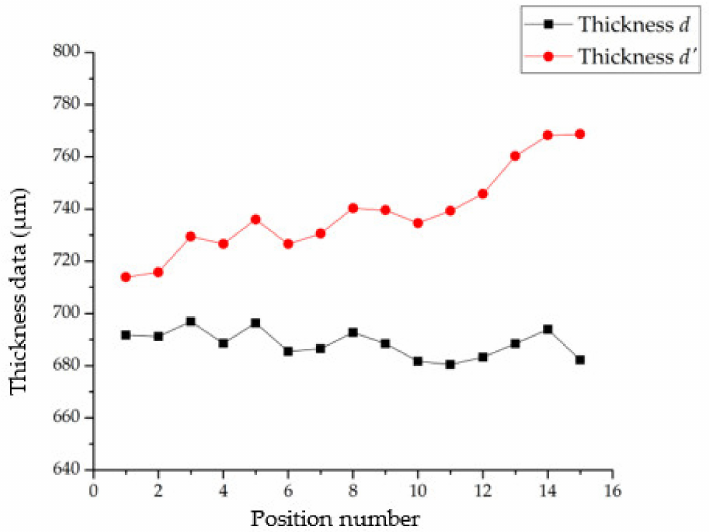
Figure 20. The thickness measurement data of Sample